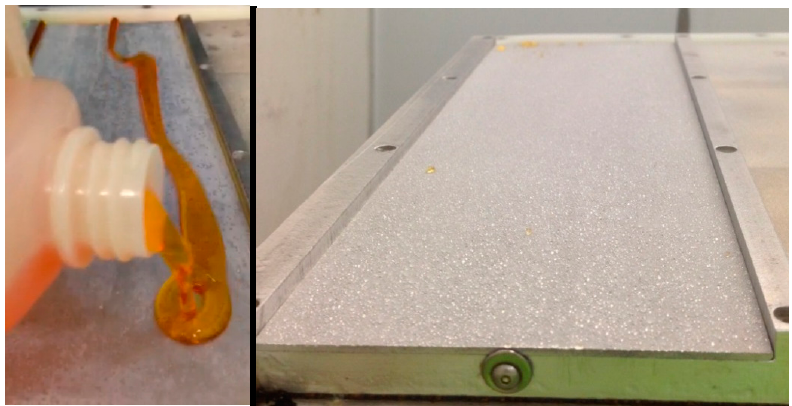
Figure 9. Wetting of the WSET plate coated with hydrophobic coating before test.